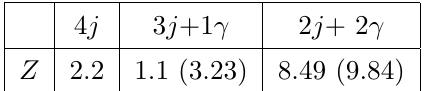
Figure 8 . Distribution of the invariant masses m j(cid:13) of the two pairs for M (cid:8) = 900 GeV (left) and 1200 GeV (right). See text for description.